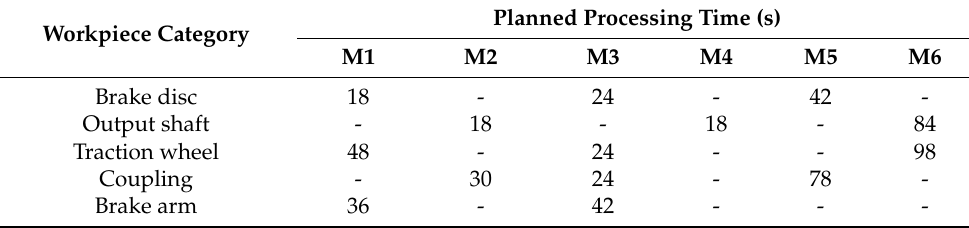
Table 6. Parts processing